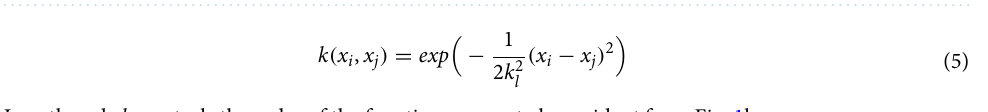
Figure 1. (a) Four samples from a multi-variate normal distribution N ( 0, �) plotted sequentially. (b) Samples from GP prior conditioned on different values of length scale l k